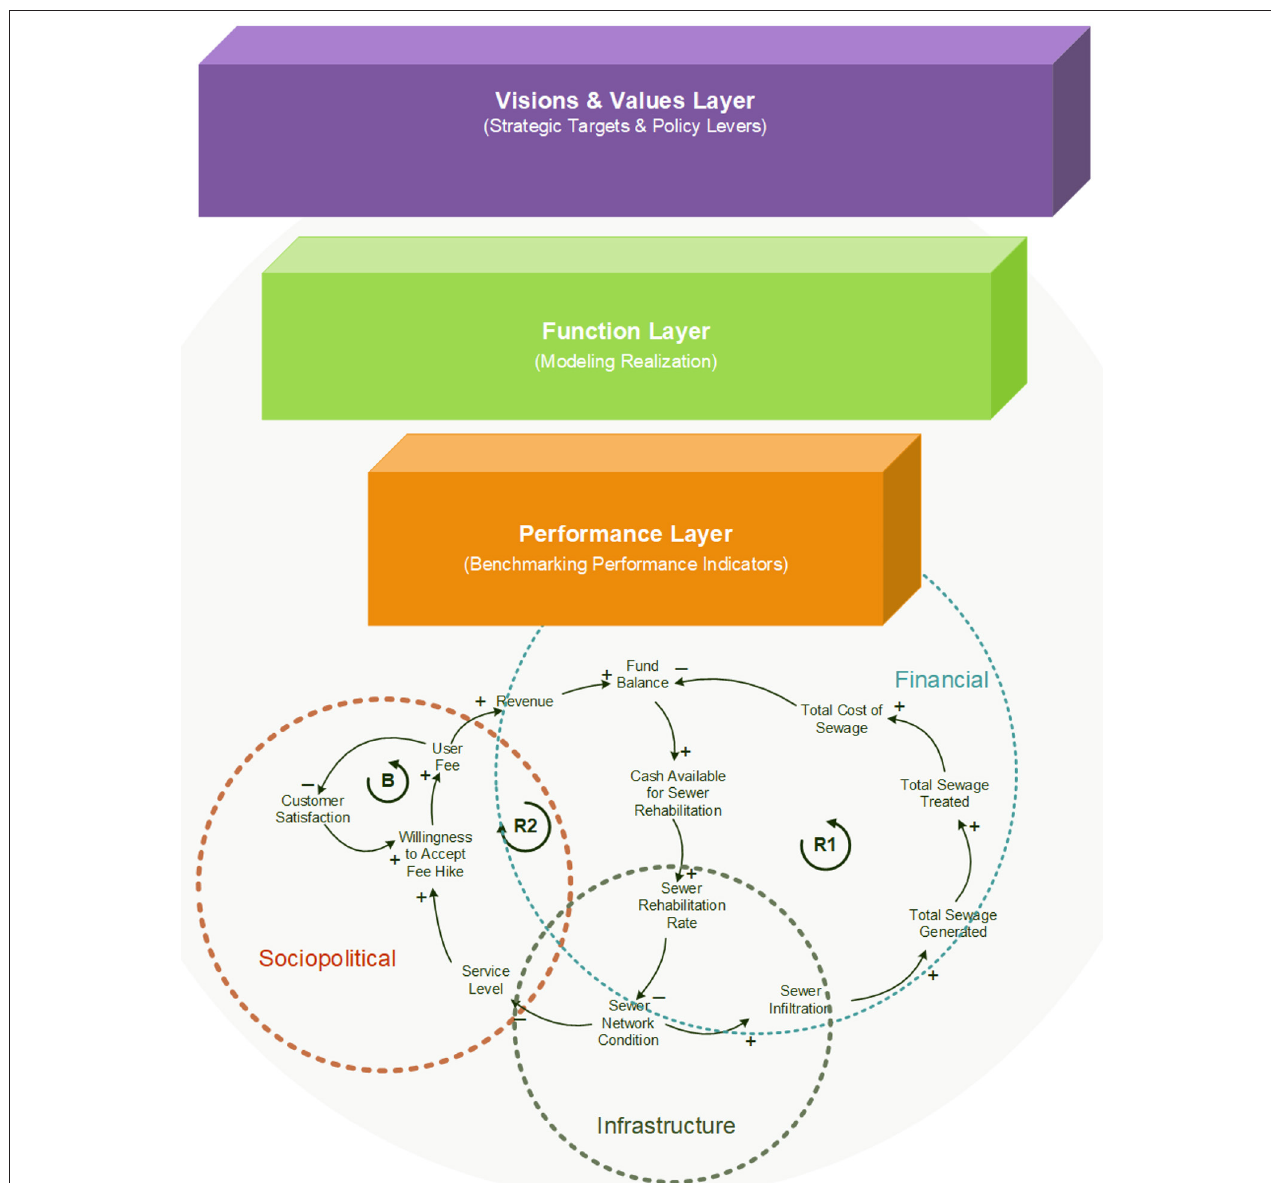
FIGURE 1 | Implementation framework for asset management strategy of wastewater collection